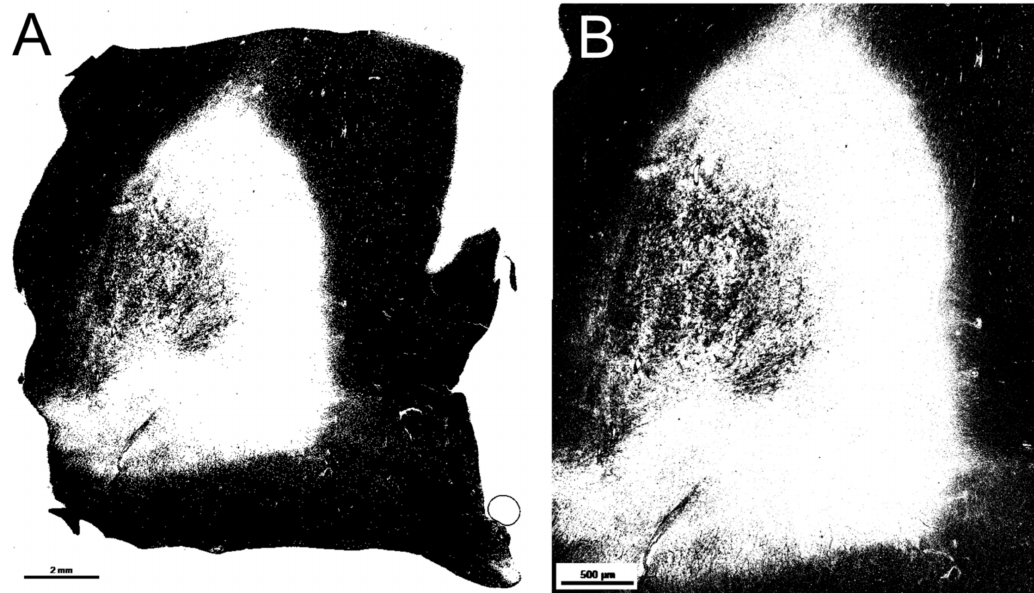
Figure 2. Remyelinated lesion (score 2) at different magnifications. ( A ) represents the lesion at magnification 0.6 × and ( B ) at magnification 1.9 × . Ratio black pixels is provided in the sub analysis above (Table 1).